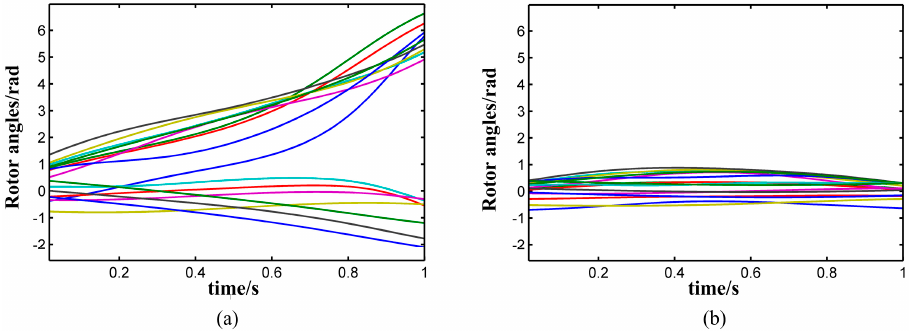
Figure 3. Generator rotor angles of 16 ‐ machine 68 ‐ bus system: ( a ) unstable case; and ( b ) stable case.